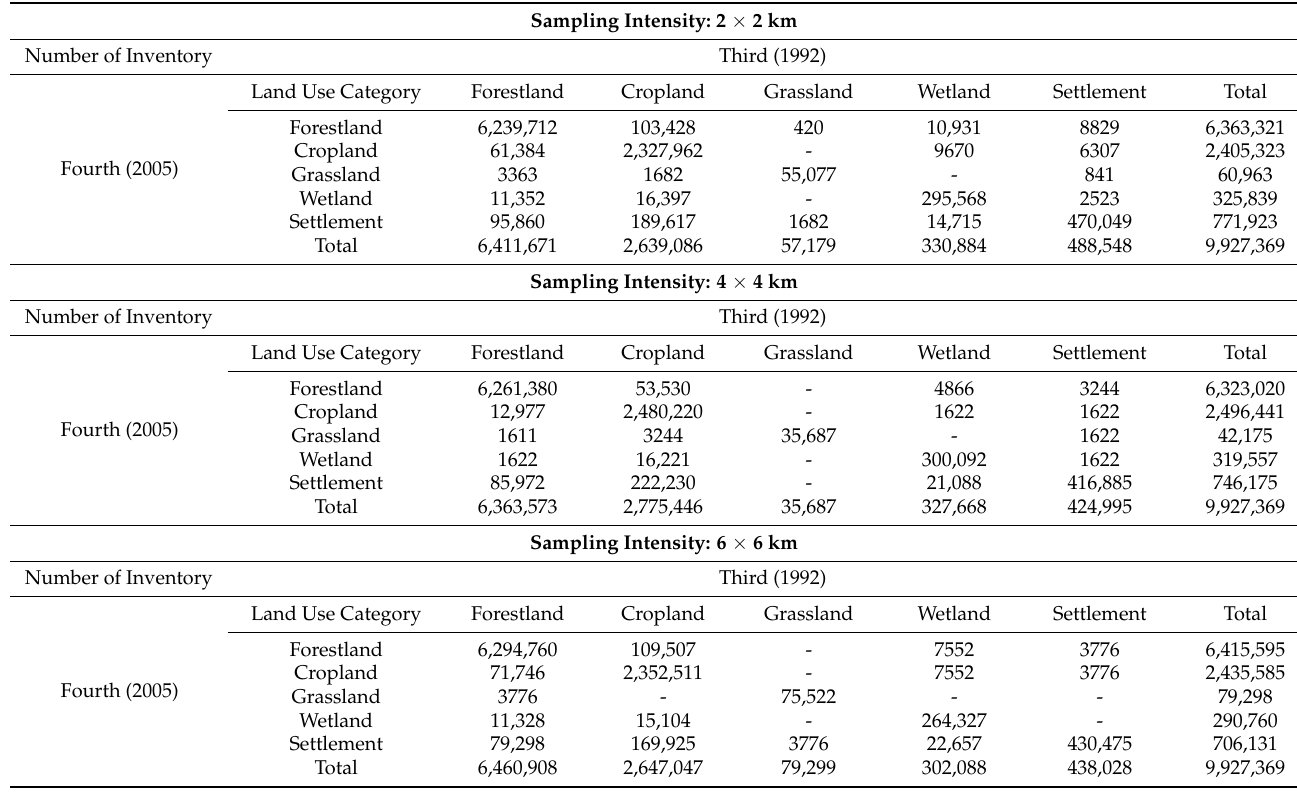
Table 3. Land-use change matrices of area (ha) by sampling intensity, as detected by analyses of 3rd (1992) and 4th (2005) aerial